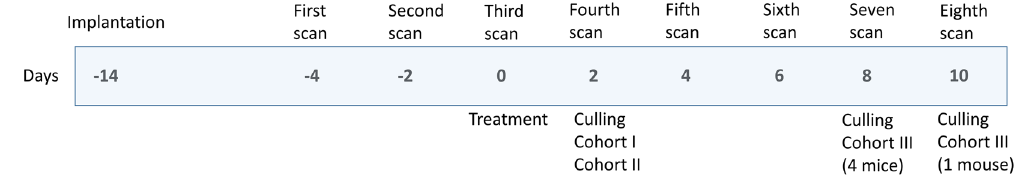
Figure 1. Timeline of the